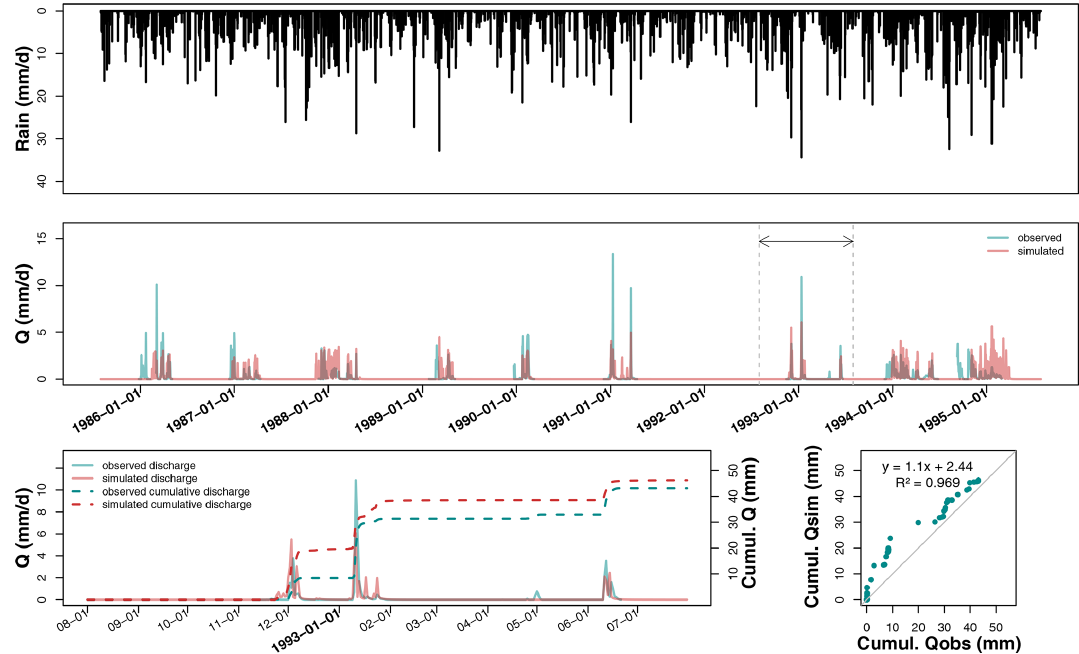
Figure 5. Hydrograph on Courcival_P3 after calibration over the entire available record, plus a magnification of the hydrological year 1992– 1993 and the associated temporal and direct comparisons between observed (blue curve) and predicted (red curve) cumulative discharges.